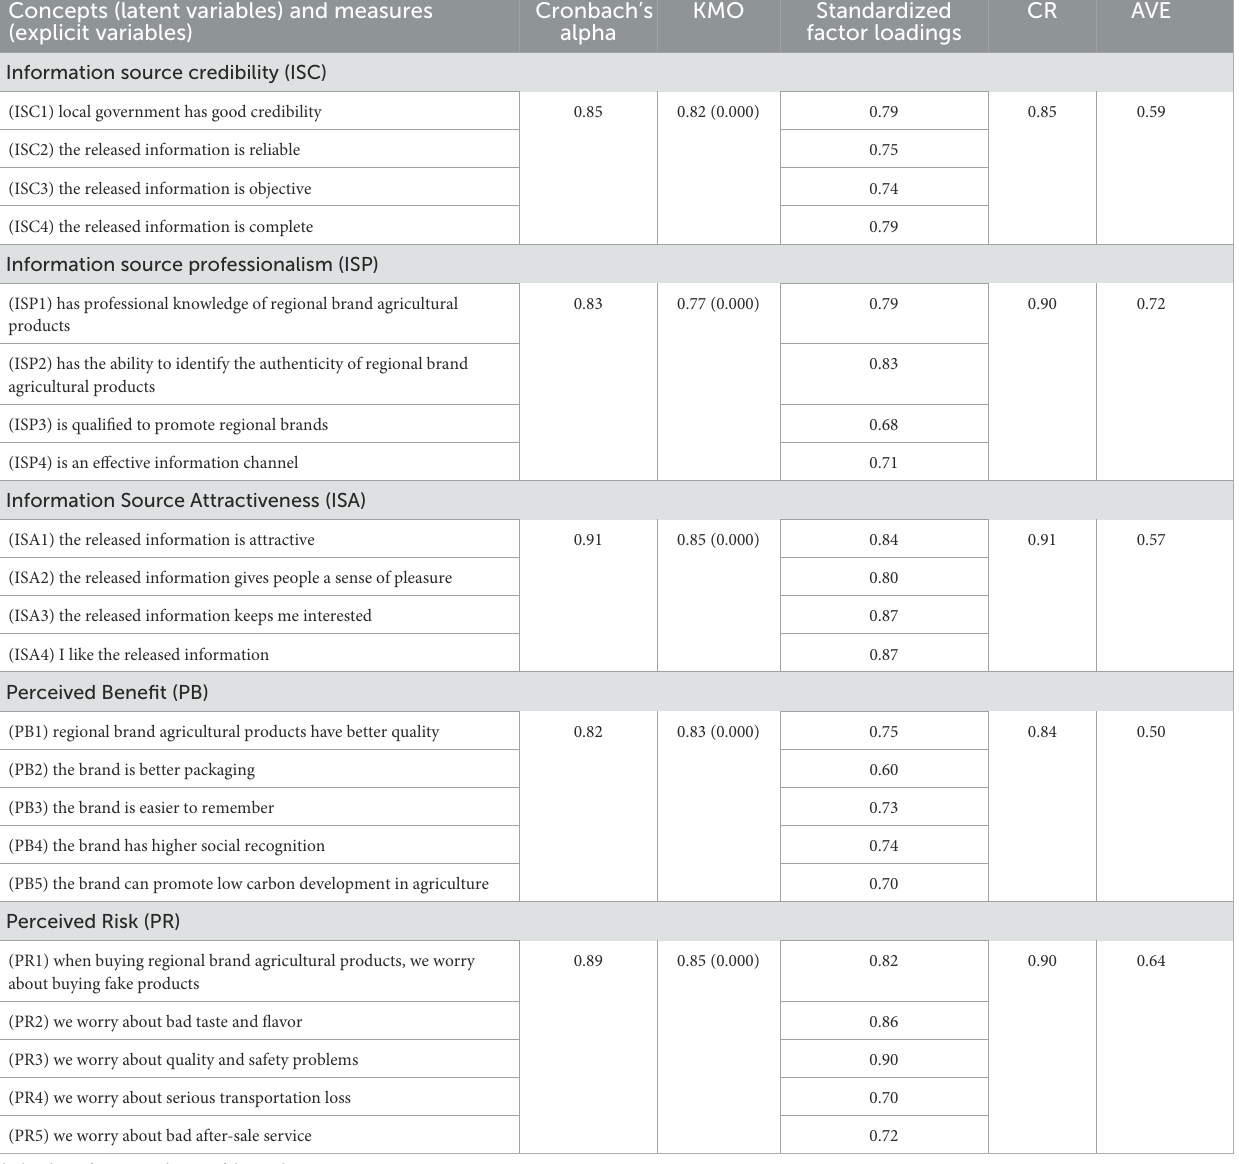
TABLE 2 Scale reliability, validity, and the confirmatory factor analysis test results. Concepts (latent variables) and measures (explicit variables)